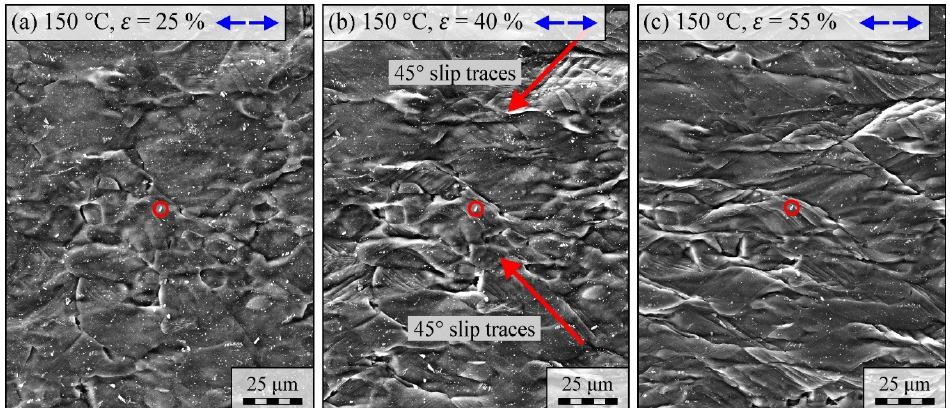
Figure 4. Example of a 150 °C simple tension specimen (loading direction indicated by blue arrows) with a tracked particle indicated by red circles and the orientation of slip traces indicated by red arrows; elongation 𝜀 indicated with reference to the initial gauge length of 3 mm being ( a ) 25%, ( b ) 40% and ( c ) 55%.